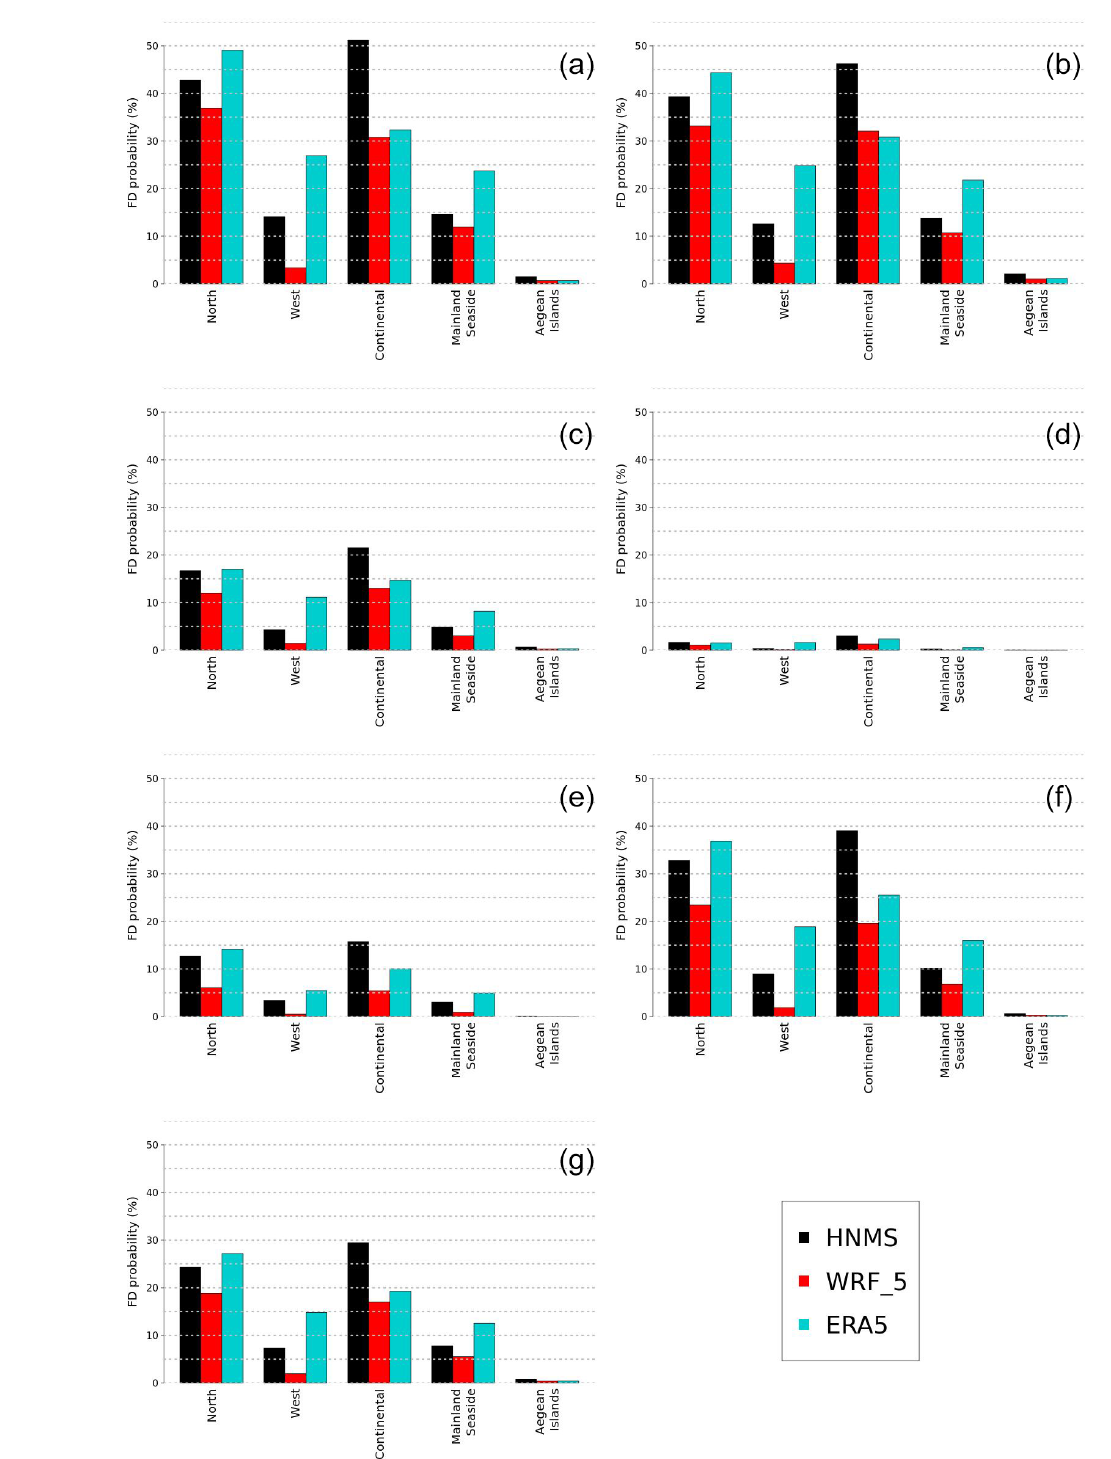
Figure B2. FD aggregated probabilities for HNMS, WRF_5 and ERA5 five station categories for the months (a) January, (b) February, (c) March, (d) April, (e) November, (f) December and (g) for the entire season November–April.